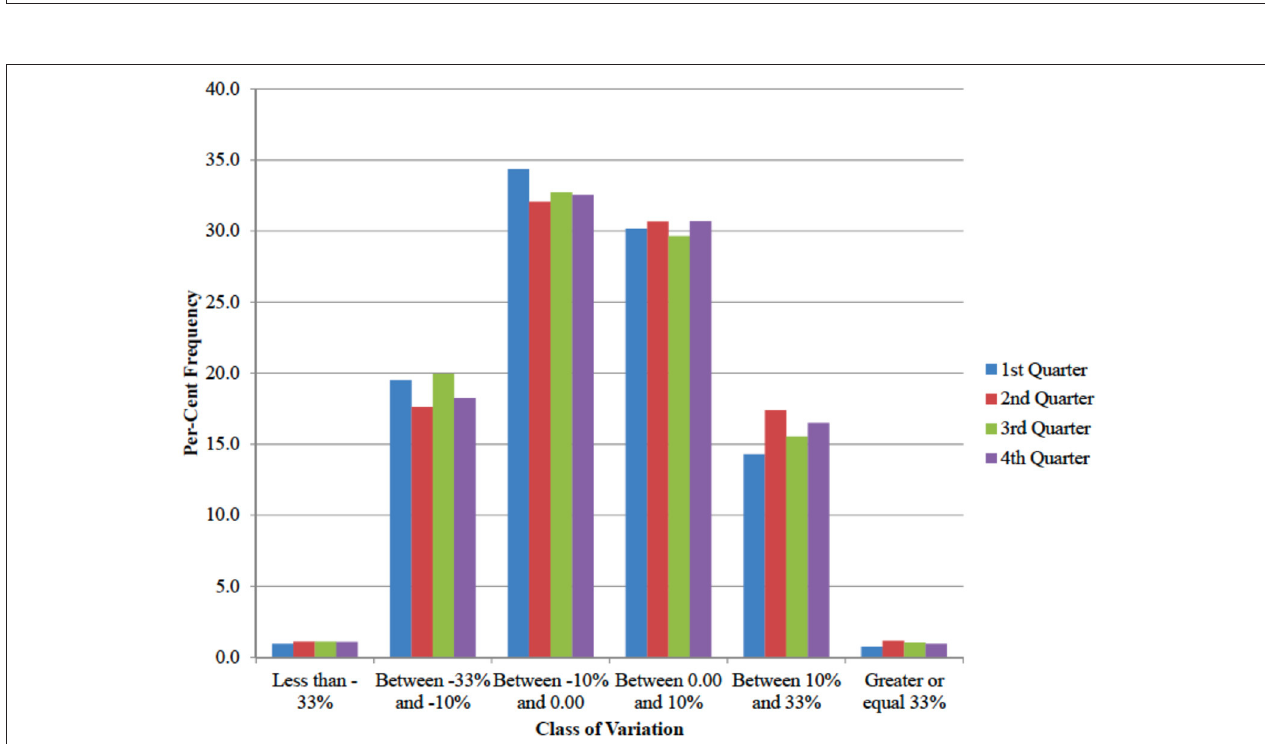
FIGURE 8 | Distribution of households by class of change in expenditure share of fresh fruit and vegetable over all fruit and vegetables. (percentage frequencies, quarters 2020 compared to same quarter in 2019).